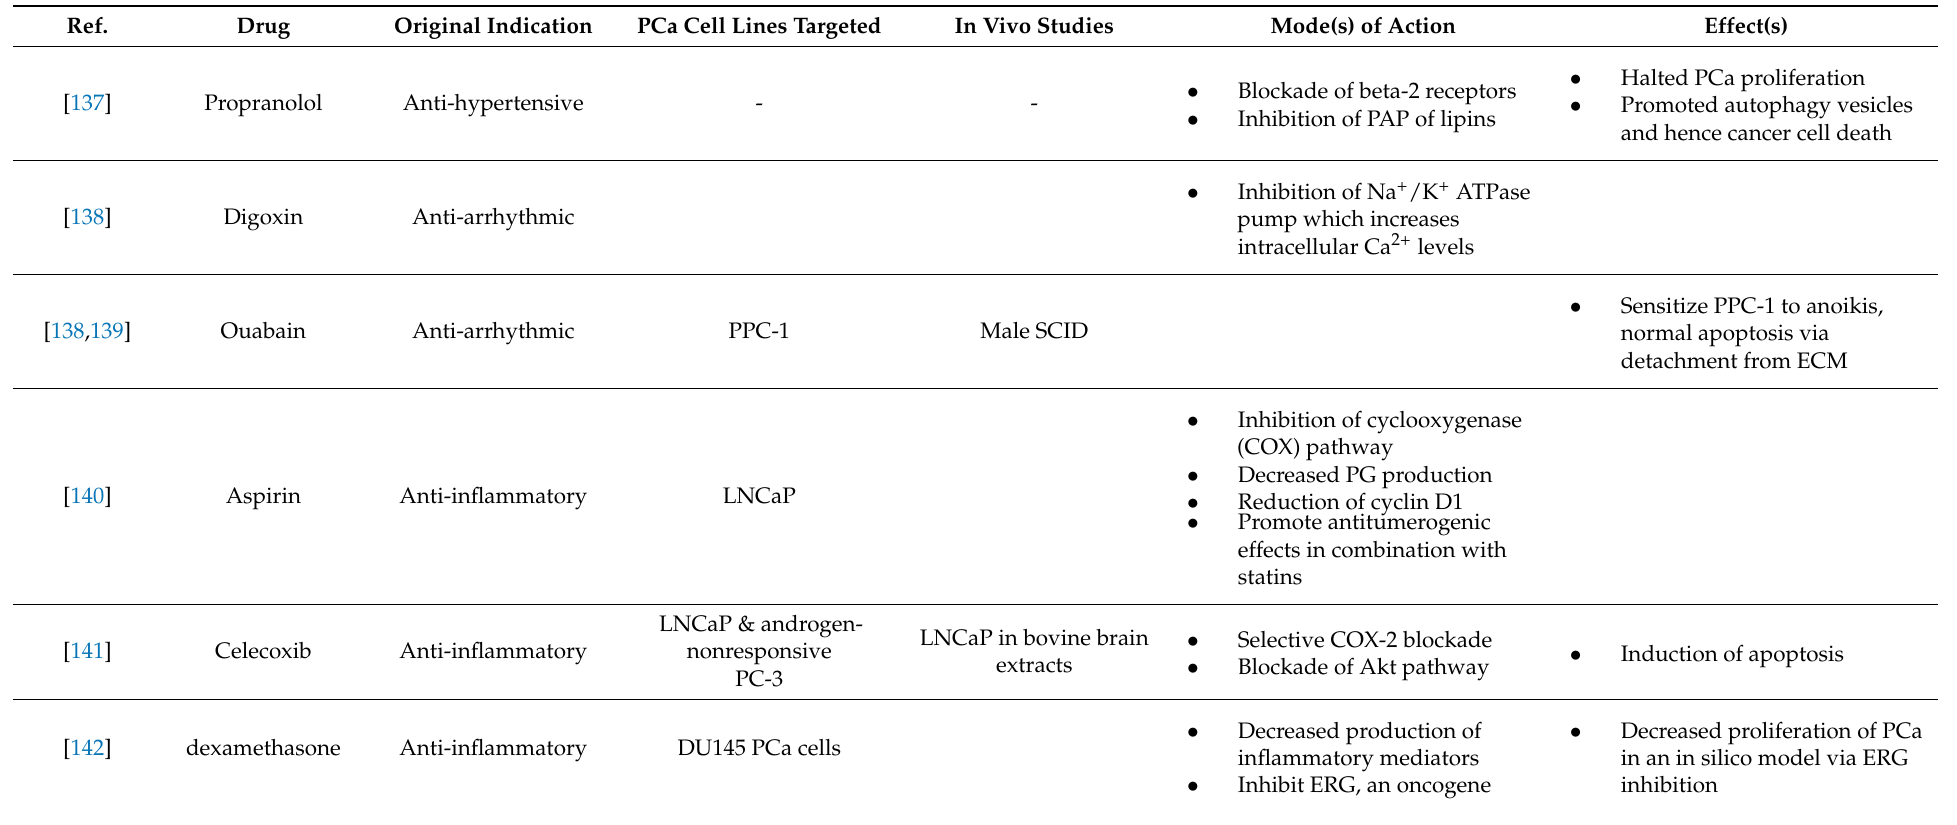
Table 1. Summary table of the drugs that have been repurposed to be used in prostate cancer in pre-clinical models.